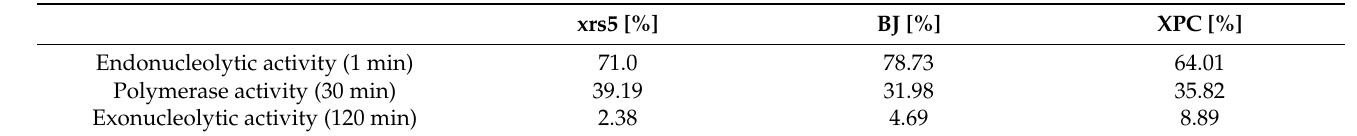
Table 1. The enzymatic activities of cytoplasmic extracts for Control 1 oligonucleotide (containing a single AP site). Raw numerical data are presented in Supplementary Materials in Tables